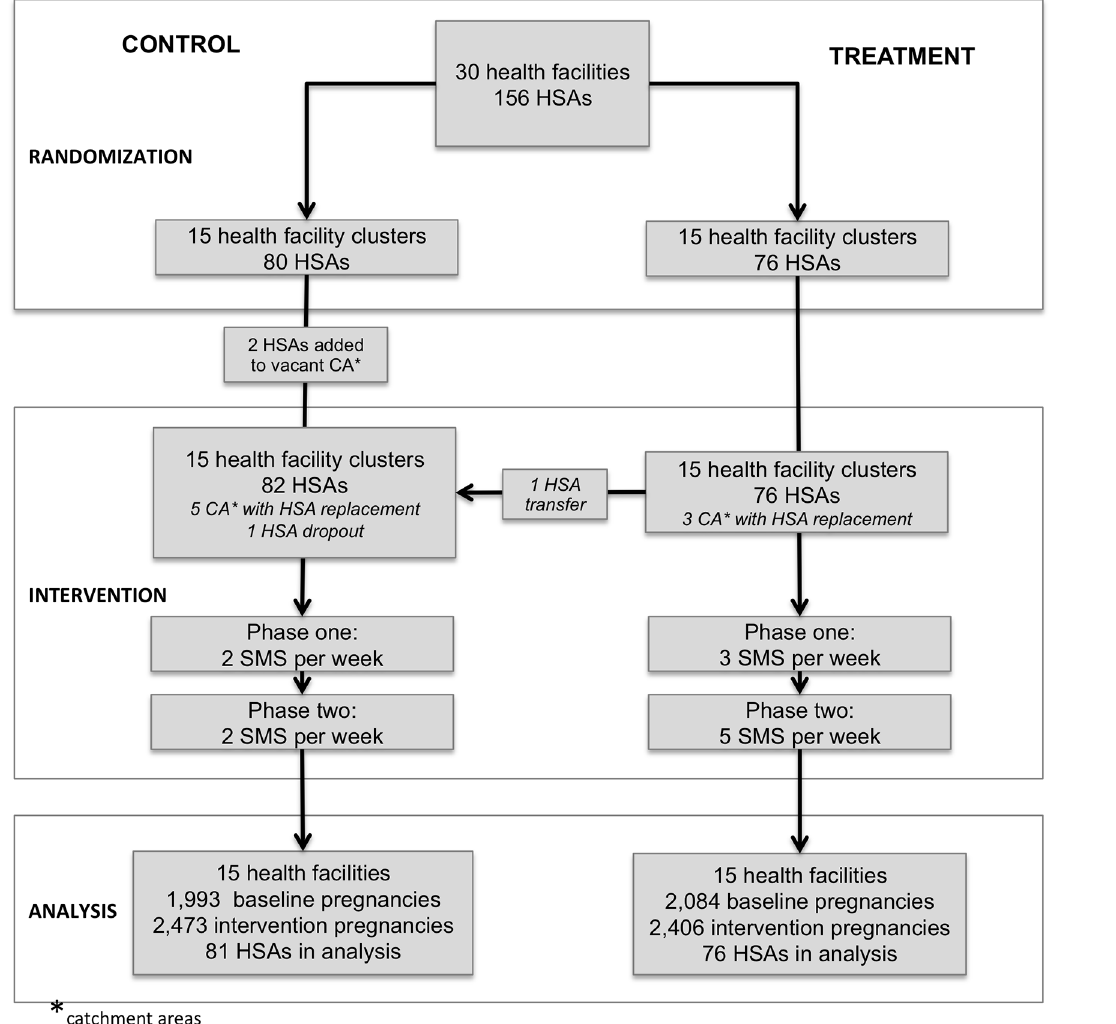
Fig 2. Trial profile. Profile of trial clusters at randomization, intervention, and analysis